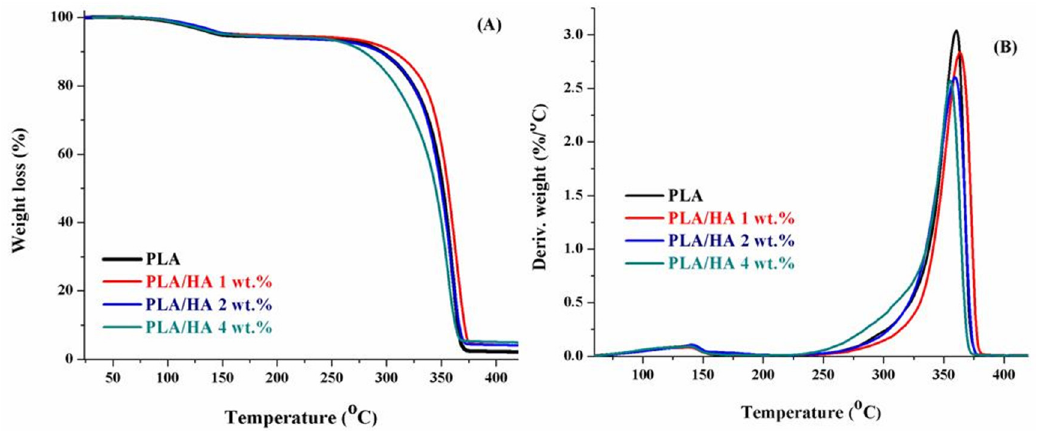
Figure 3. ( A )Thermogravimetricanalysis(TGA)and( B )DTGcurvesofPLAandPLA / HAcompositefilms.